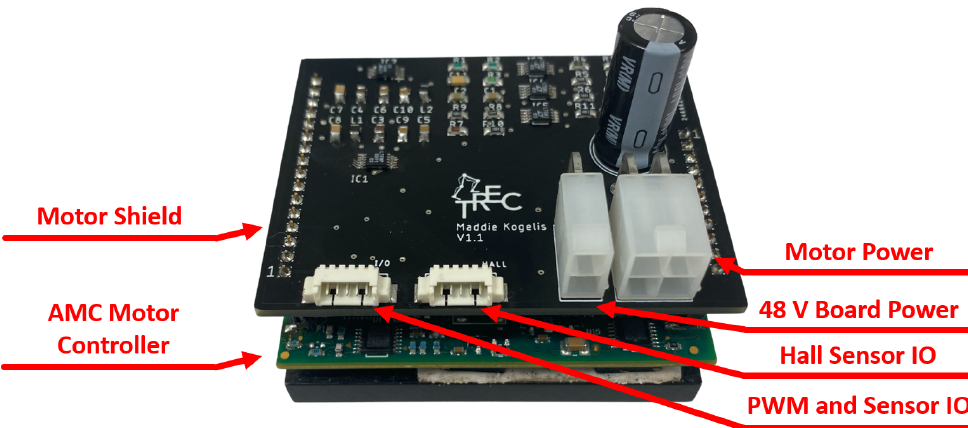
Figure 8. The motor control unit is a combination of an off-the-shelf AMC AZBDC12A8 motor controller and the in-house-designed motor